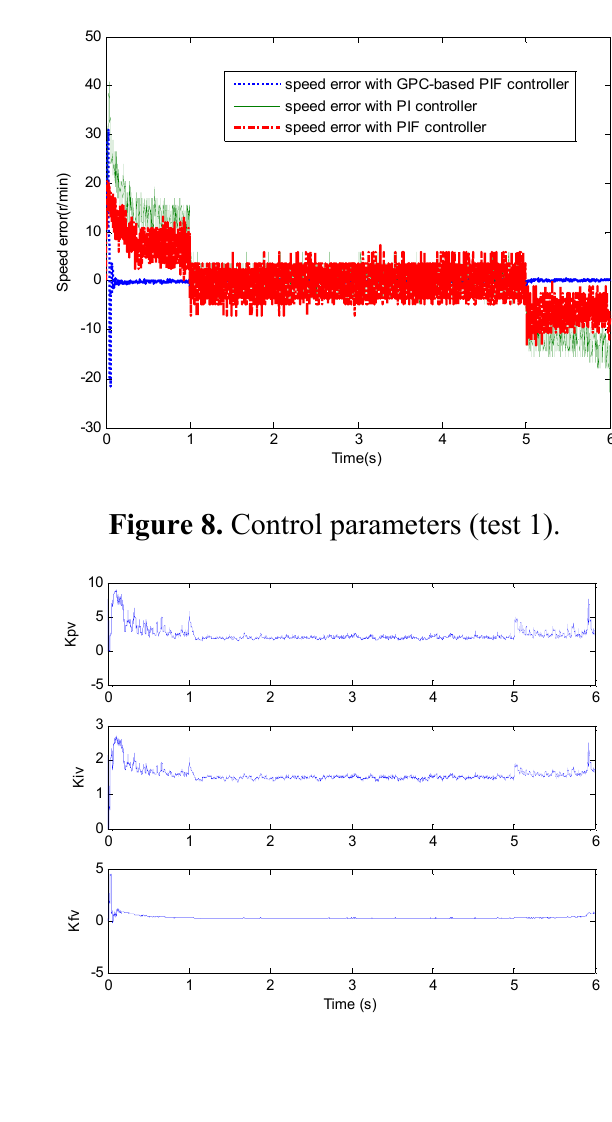
Figure 7. Speed error (test 1).